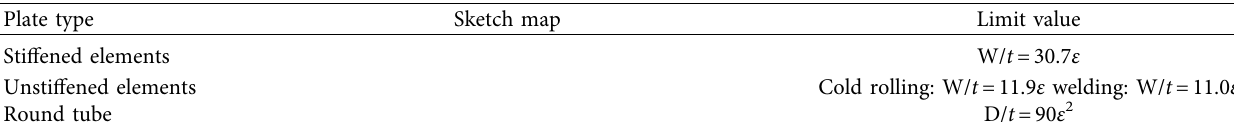
Table 2: Lower limit for sections of class 3 in the European code